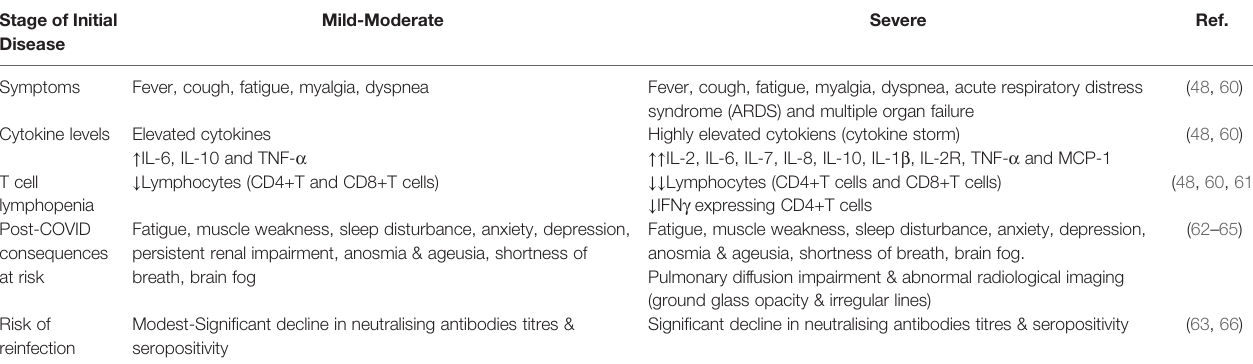
TABLE 2 | Comparison between non-severe and severe